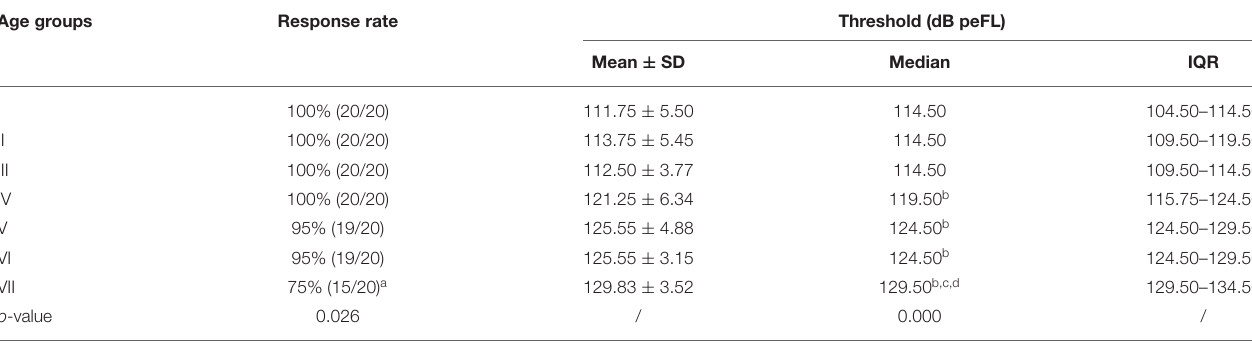
TABLE 1 | The response rate and threshold of B81-cVEMP with increasing age. Age